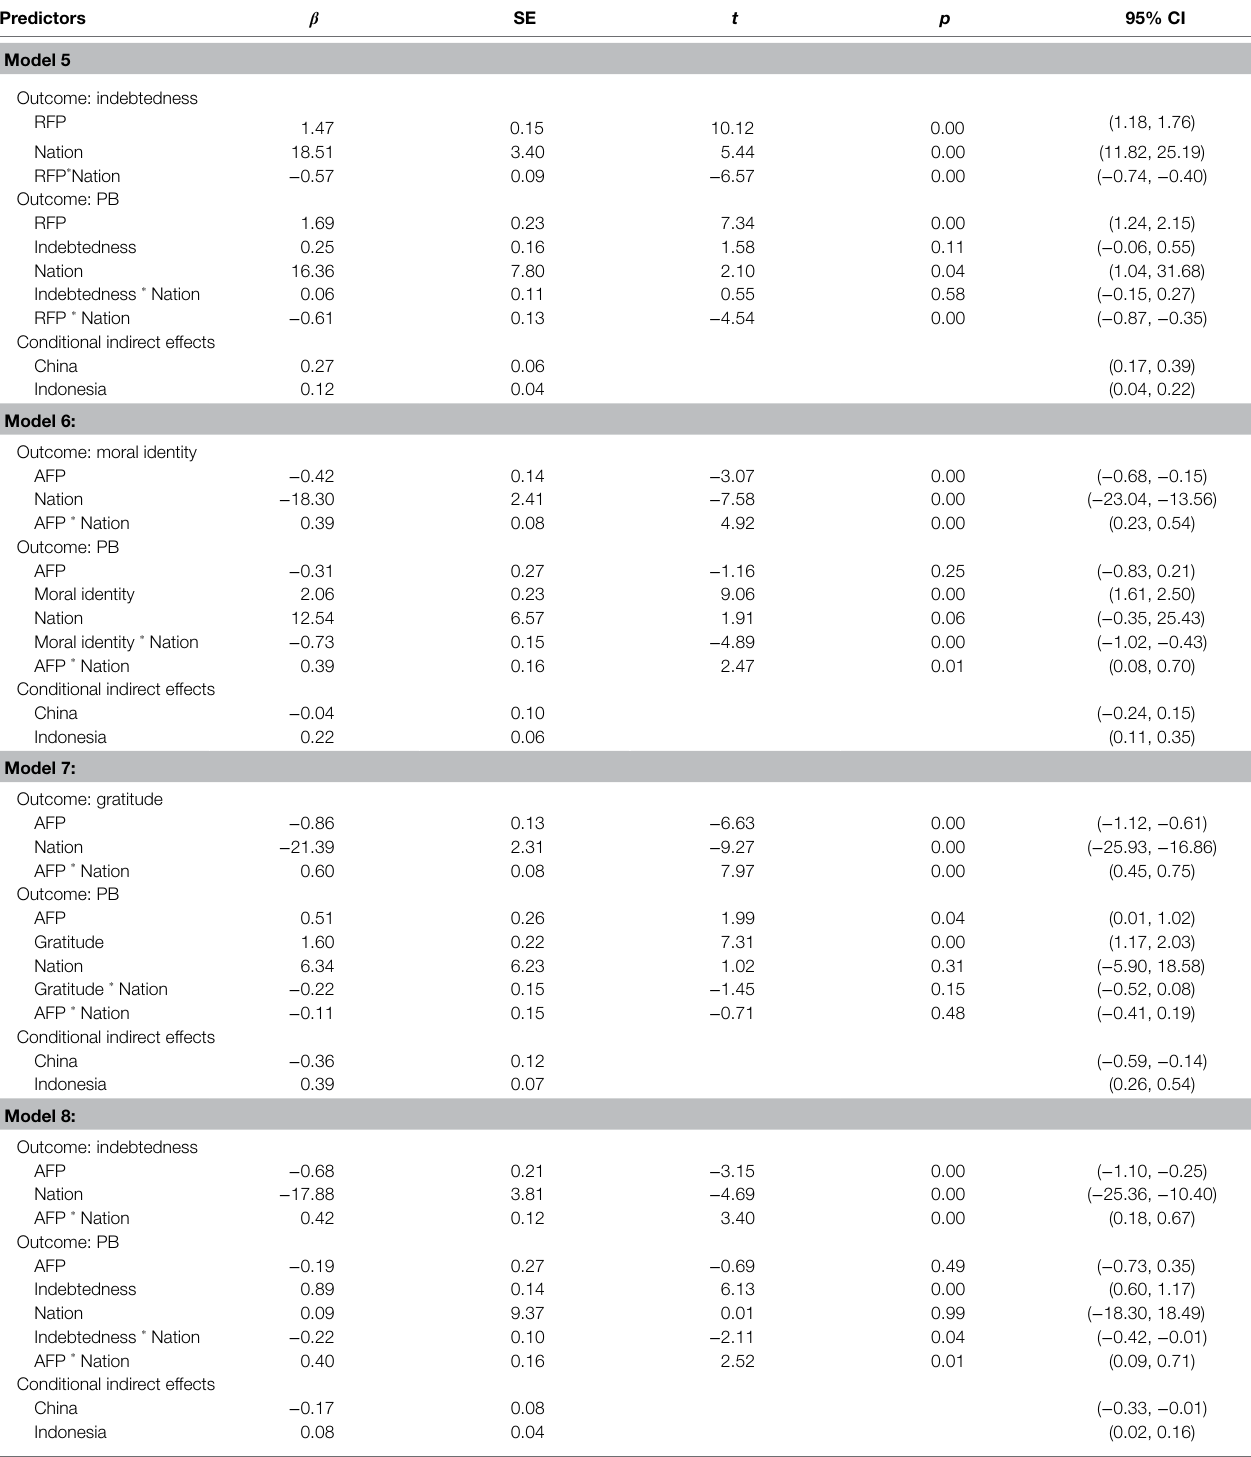
TABLE 3 | Testing for moderated